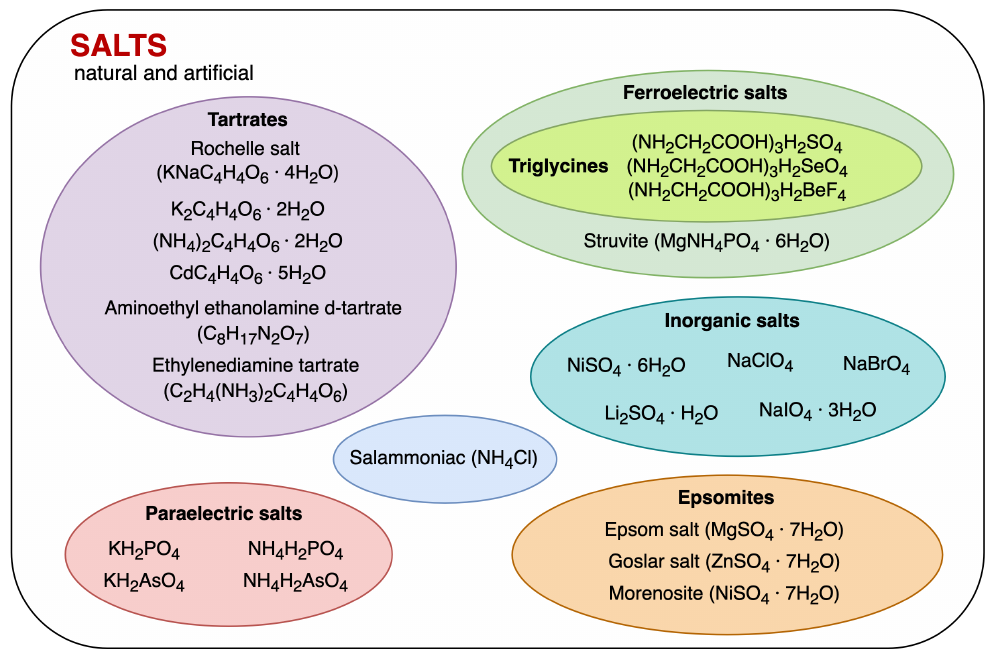
Figure A3. The class of salts including tartrates, epsomites, salammoniac, ferroelectric, paraelectric and inorganic